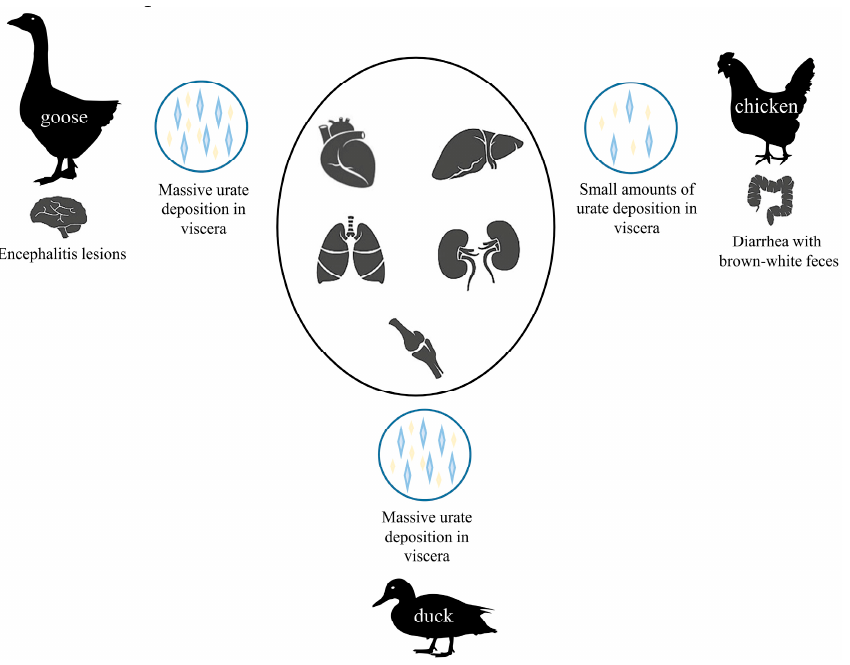
Figure 5. Pathogenicity of 3 different types of animal (goose, duck, chicken) infected with Go-